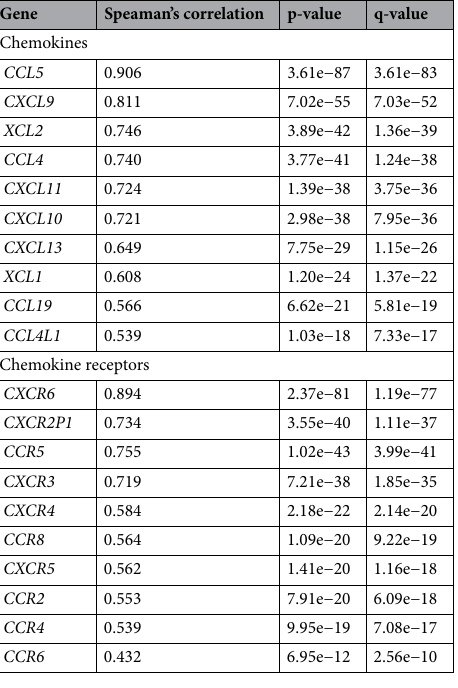
Table 2. Chemokines and chemokine receptors, whose mRNA levels were significantly correlated to CD8A mRNA level in TCGA data set. Top 10 chemokines and chemokine receptors showing positive correlation to CD8A mRNA level in Lung Adenocarcinoma data set (TCGA, Nature 2014) are presented according to the order of Spearman’s